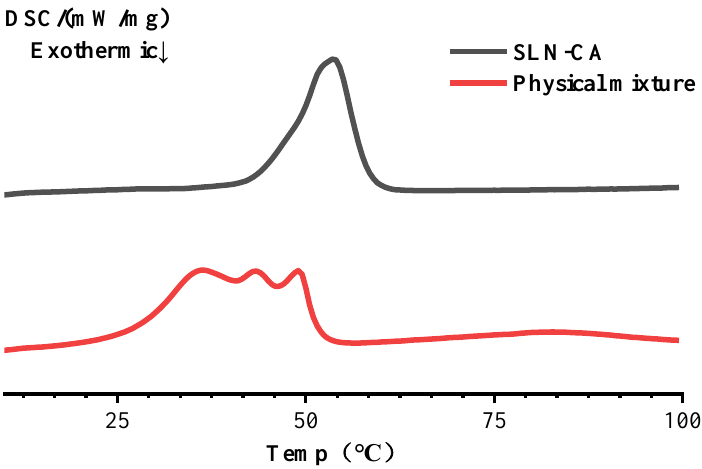
Figure 10. DSC scan results of SLN-CA with the physical mixture.